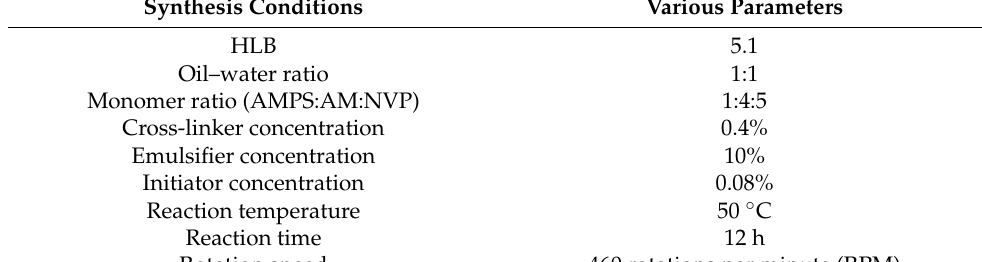
Table 4. The synthesis conditions of AMN other than total monomer concentration.